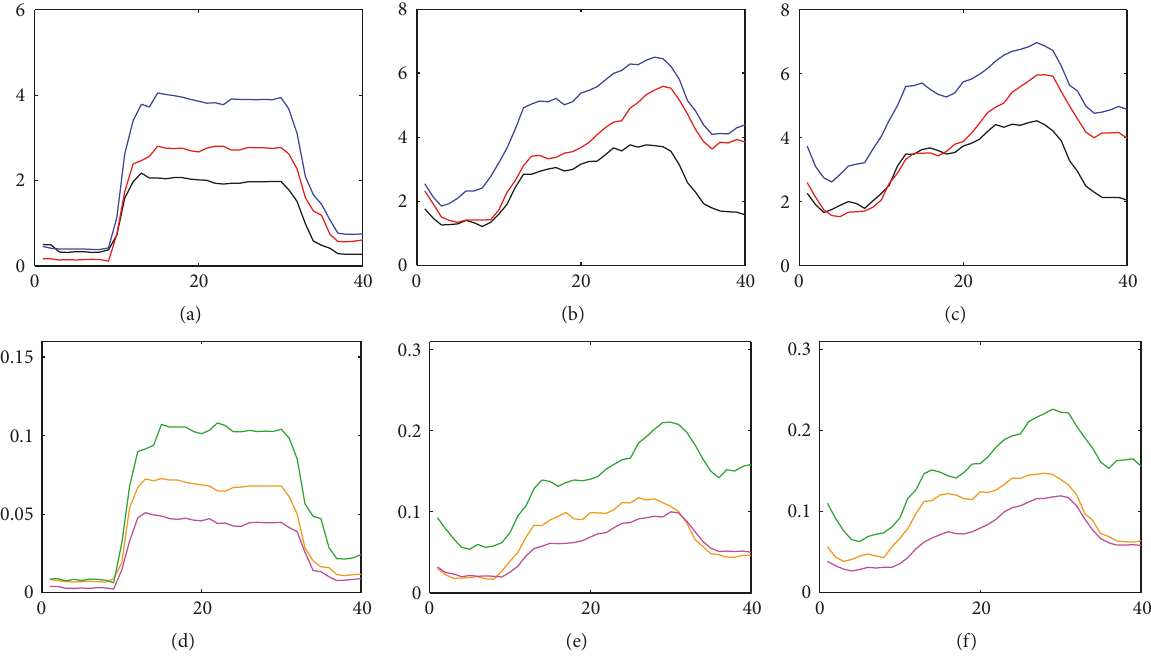
Figure 11: The GACS and ACGCS values using different 𝛼 values in formula (6). (a) GACS values using 𝛼 = 0.01 . (b) GACS values using 𝛼 = 0.1 . (c) GACS values using 𝛼 = 0.15 . Europe (blue line), Asia (black line), and America (red line). (d) ACGCS values using 𝛼 = 0.01 . (e) ACGCS values using 𝛼 = 0.1 . (f) ACGCS values using 𝛼 = 0.15 . Europe–America group (green line), Asia–Europe group (yellow line), and America–Asia group (magenta